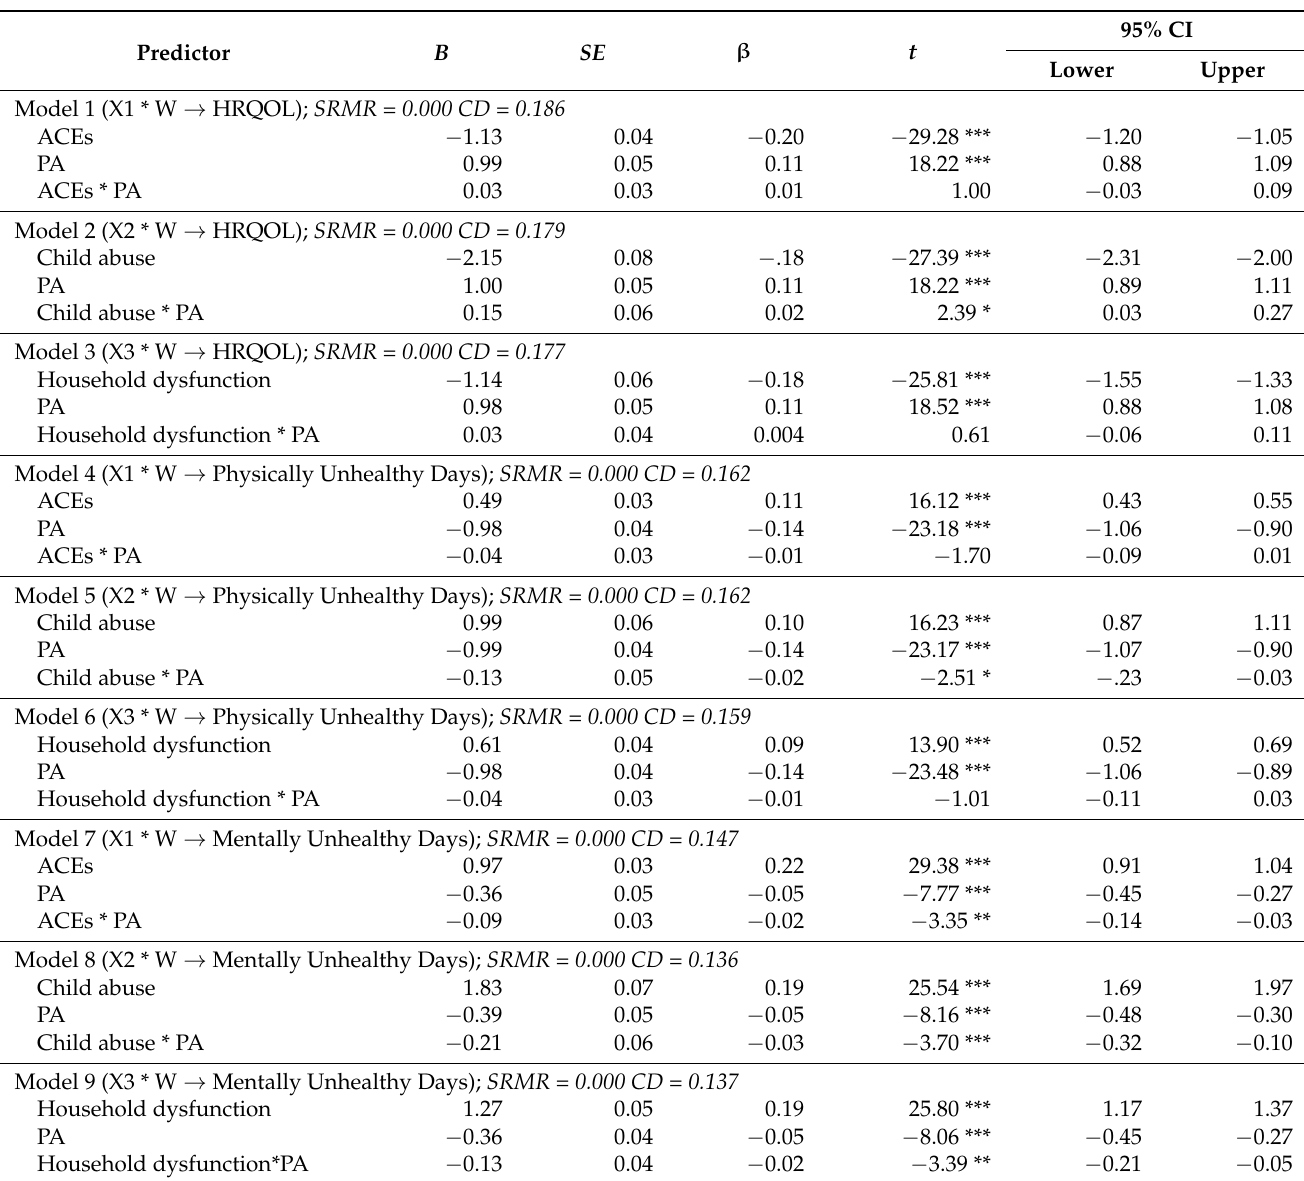
Table 4. Moderation analysis of PA on the relationships between comorbidity, psychological distress, and HRQOL ( n =